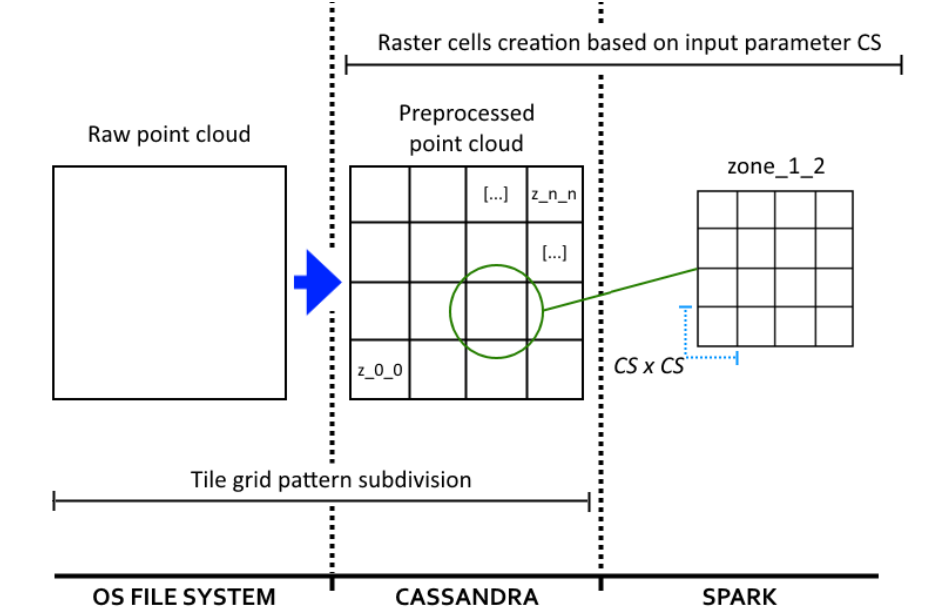
Figure 1. Data divisions carried out during the whole computational process. During an offline preprocessing stage, raw point clouds are divided following a tile grid pattern. Then, each tile (or zone) is inserted and stored permanently in Cassandra. During runtime, a raster is created for each zone by subdividing the zone into cells whose dimensions are defined by the input parameter CS